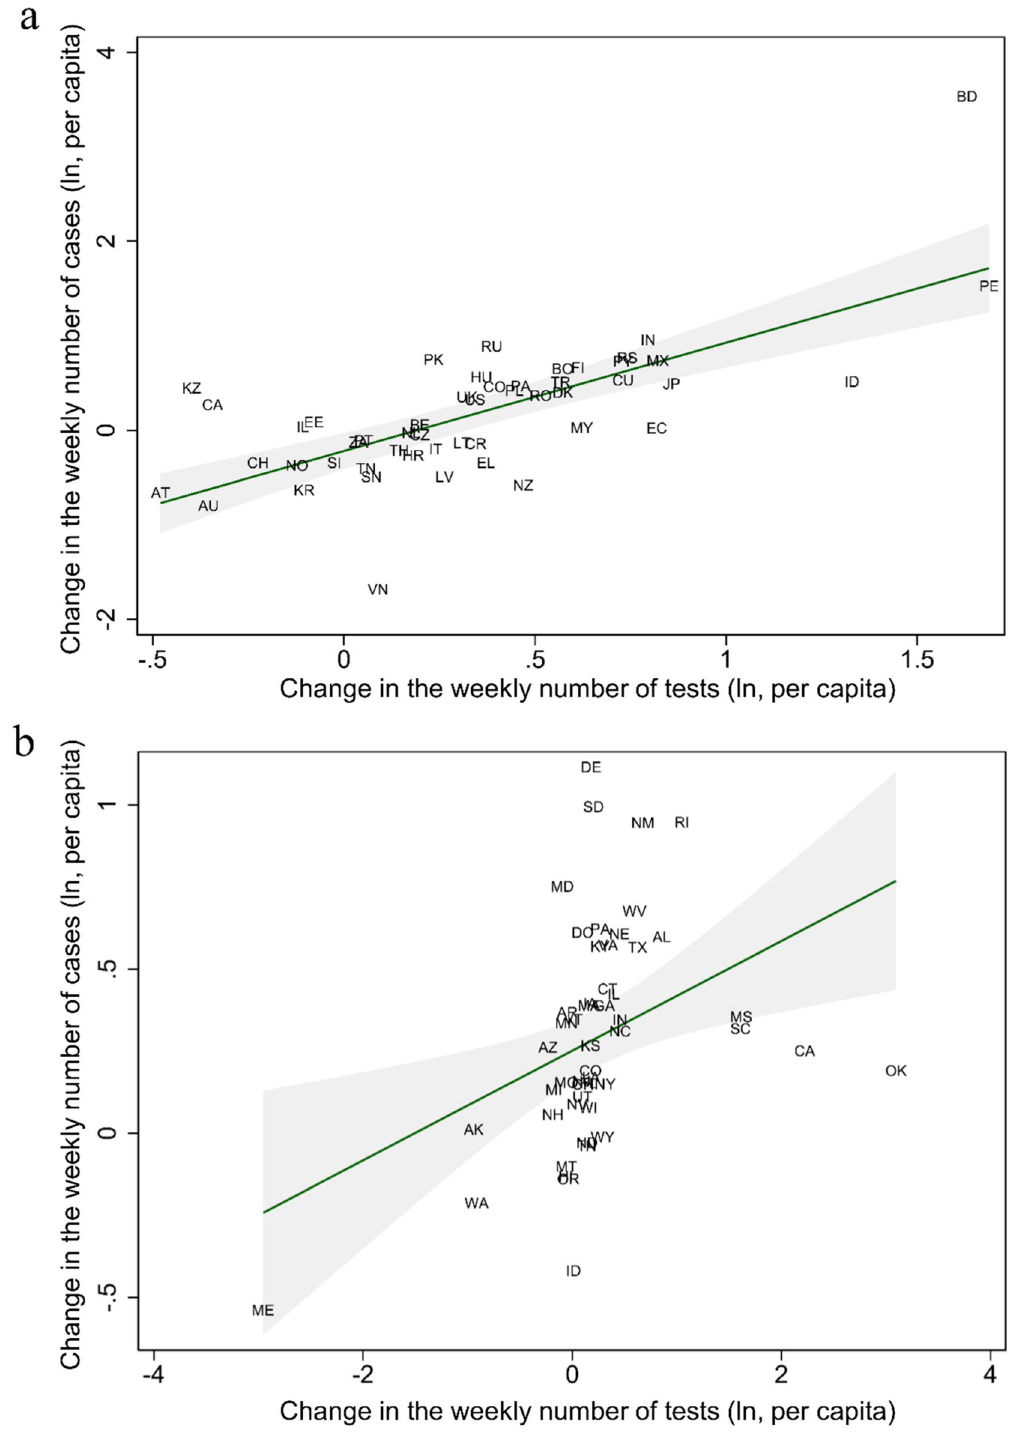
Figure 1. Changes in Covid-19 cases per capita relative to changes in the number of tests for countries and states in the USA. Panels show the growth in weekly cases and tests (in logarithms of the per capita rate) for ( A ) countries and ( B ) States in the USA that have reported Covid-19 cases. Data compares the week ending April 10th, 2020, with the previous week. ( A ) β = 0.86; 95% CI 0.57–1.15; p < 0.001; ( B ) β = 0.17; 95% CI 0.03–0.31; p = 0.02. The Supplementary material shows a higher elasticity for ( B ) if we restrict logarithmic week-on-week changes of testing rates between − 1 and + 1.5, the range observed in the global sample. In Supplementary Material, Figure S1: β = 0.54, p < 0.0001, 95%CI: 0.36–0.71. Names and abbreviations for countries and US States are included in the Supplementary Material’s Table